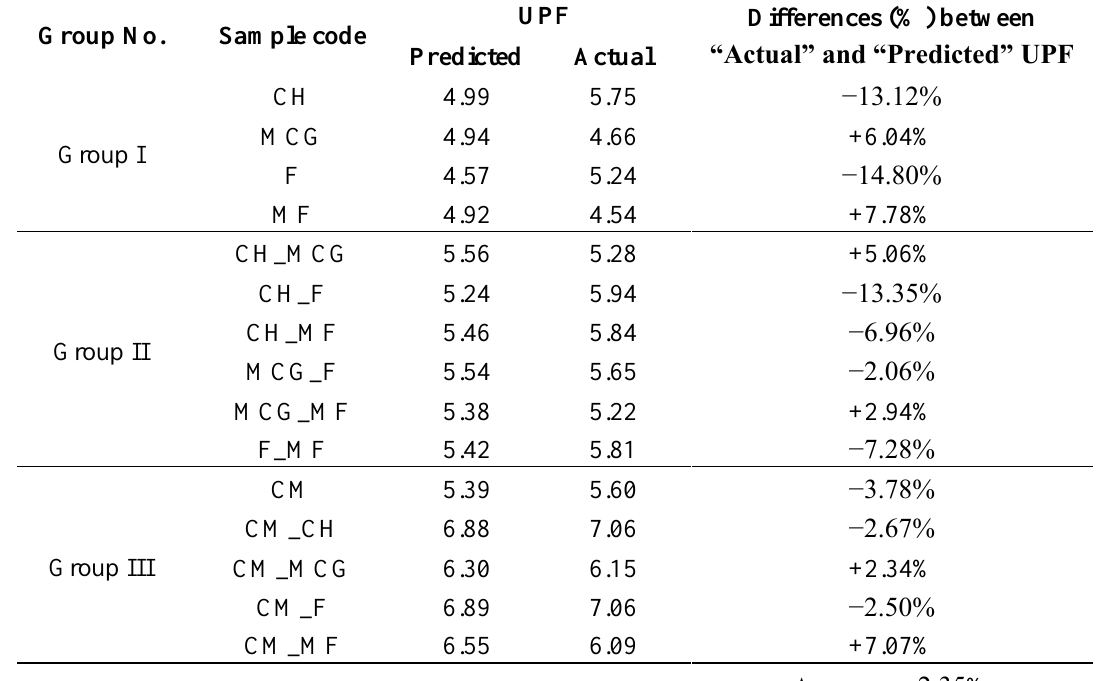
. dry and stretched